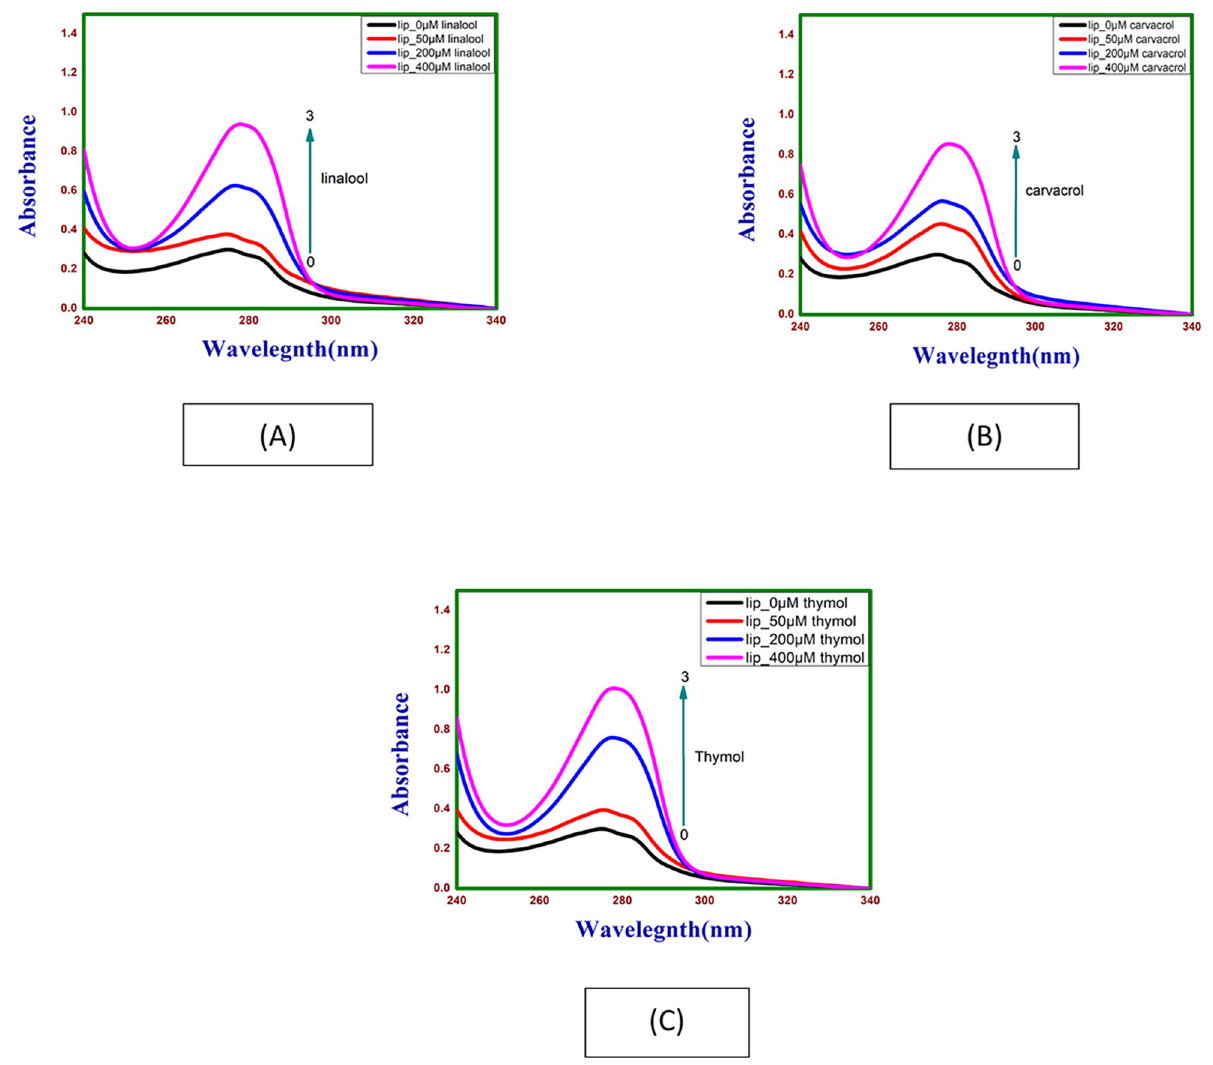
Fig 4. Absorption spectra of lipase as a function of (A) linalool, (B) carvacrol and (C) thymol concentration at 298.15 K and pH 7.4.